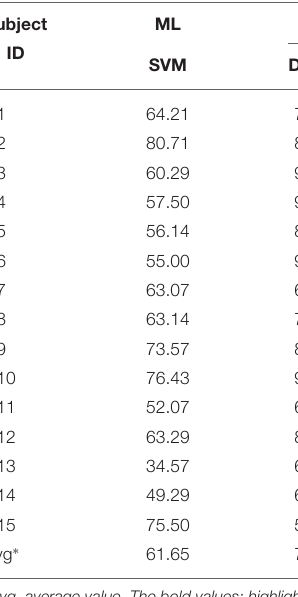
TABLE 2 | Classification accuracy performance of individuals